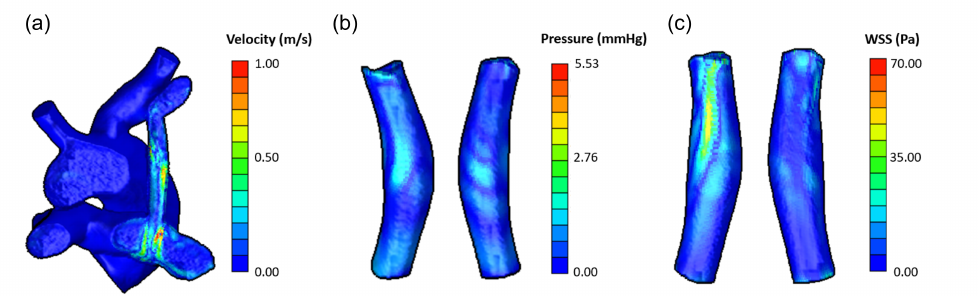
Figure 8. Wall Shear Stress distribution comparison between the CFD ( a – d ) and the ROM ( e – h ) flow field ( e – h ) for four different validation scenarios using two perspectives: No.65 ( a – e ), No. 52 ( b – f ), No. 63 ( c – g ), No. 87 ( d – h ).